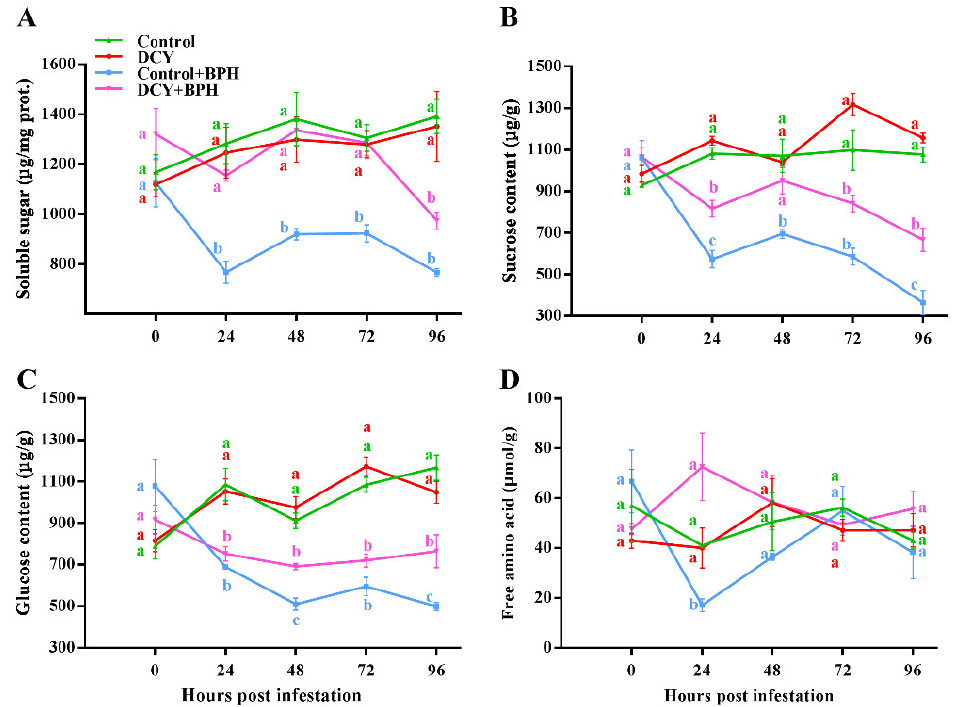
Figure 3. Changes in nutrient content in rice sheaths’ responses to DCY treatment and BPH infestation: ( A ) soluble sugar, ( B ) sucrose, ( C ) glucose, and ( D ) free amino acid. Data represent means ± standard error of three replicates. Different letters at a certain time point post-BPH infestation indicate significant differences ( p < 0.05, Tukey’s HSD test).